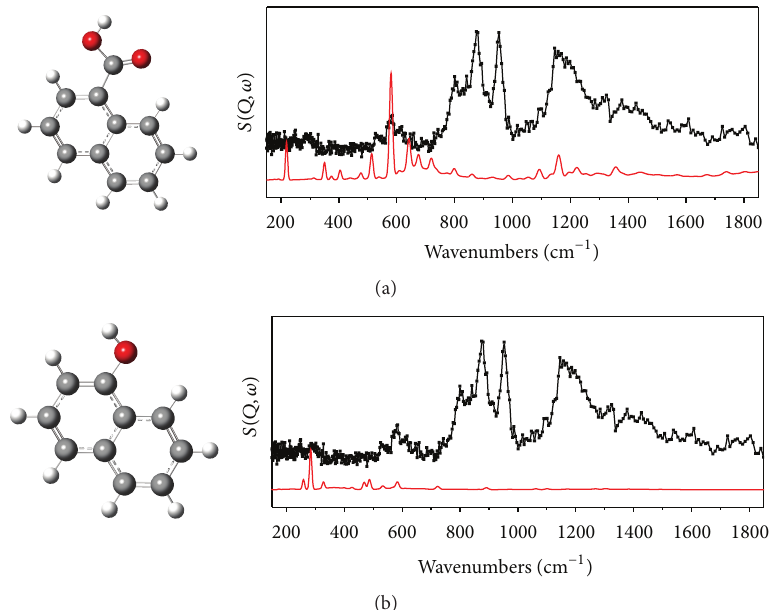
Figure 4: Simple models of a carbon fragment with an oxygen-containing functional group: (a) carboxyl and (b) phenol. The computed INS spectrum is obtained by putting the cross section of all the C and H atoms belonging to the aromatic rings artificially to 0 barns. The resulting spectra highlight the contribution of the selected species attached to the carbon cluster only. Calculated spectra (red curves) are compared to the experimental INS spectrum of CW (dotted